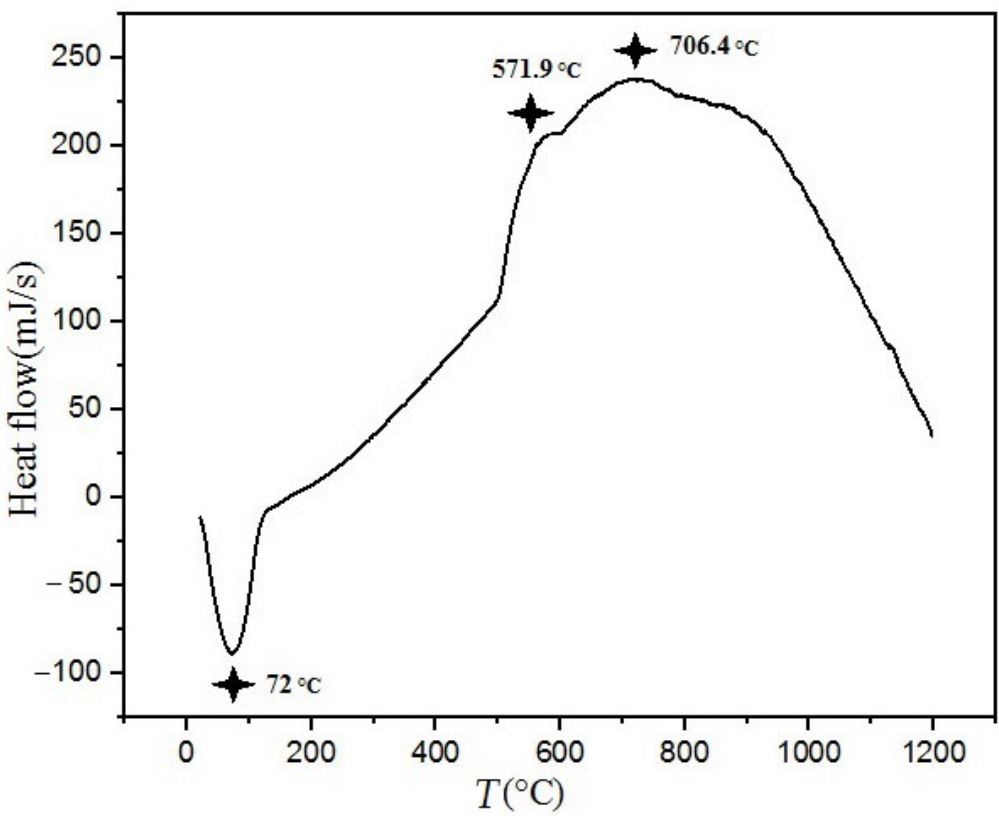
Figure 8. Differential Scanning Calorimetry ( DSC) curve of AlCrCuFeNi HEA.